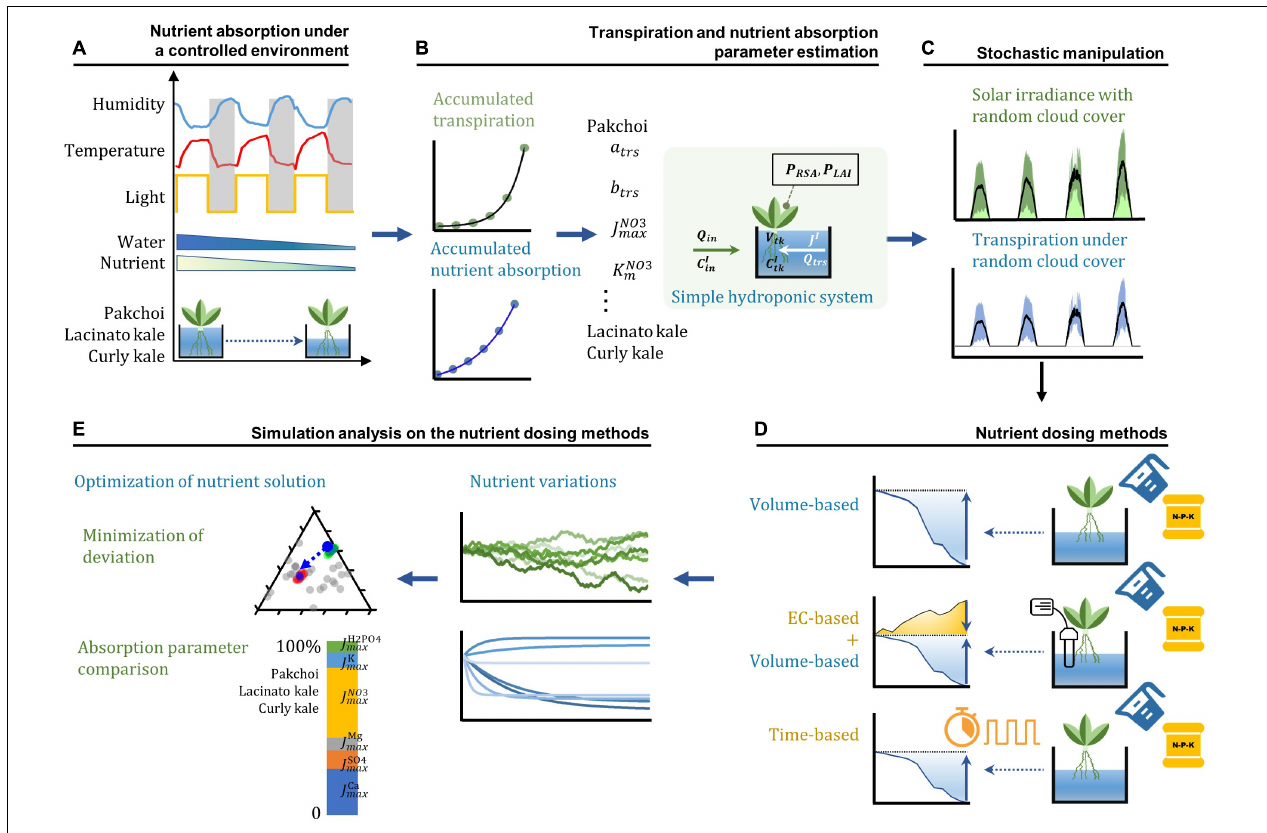
FIGURE 1 | The workflow of the theoretical and experimental analysis setup. (A) Nutrient absorption measurement of three Brassica species under a controlled environment. (B) Parameter estimation process under the simple hydroponic system model by using the progress curve analysis. (C) Stochastic manipulation of solar irradiance with a random walk generated cloud cover and subsequent transpiration rate variations in the simple hydroponic system model. (D) Three nutrient dosing processes in the simulation analysis. (E) Simulation analysis of the nutrient dosing effects on the nutrient variations and nutrient solution optimization.